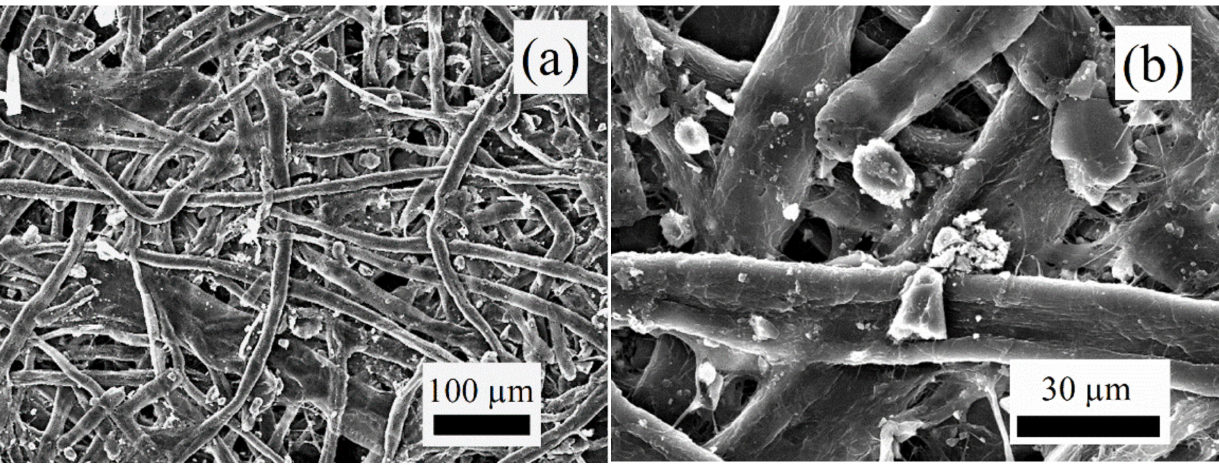
Figure 4. SEM micrographs of the paper cards used for blade sharpness test shows paper fibers with abrasive SiO 2 particles ( a ) and enlarged view of those SiO 2 particles ( b